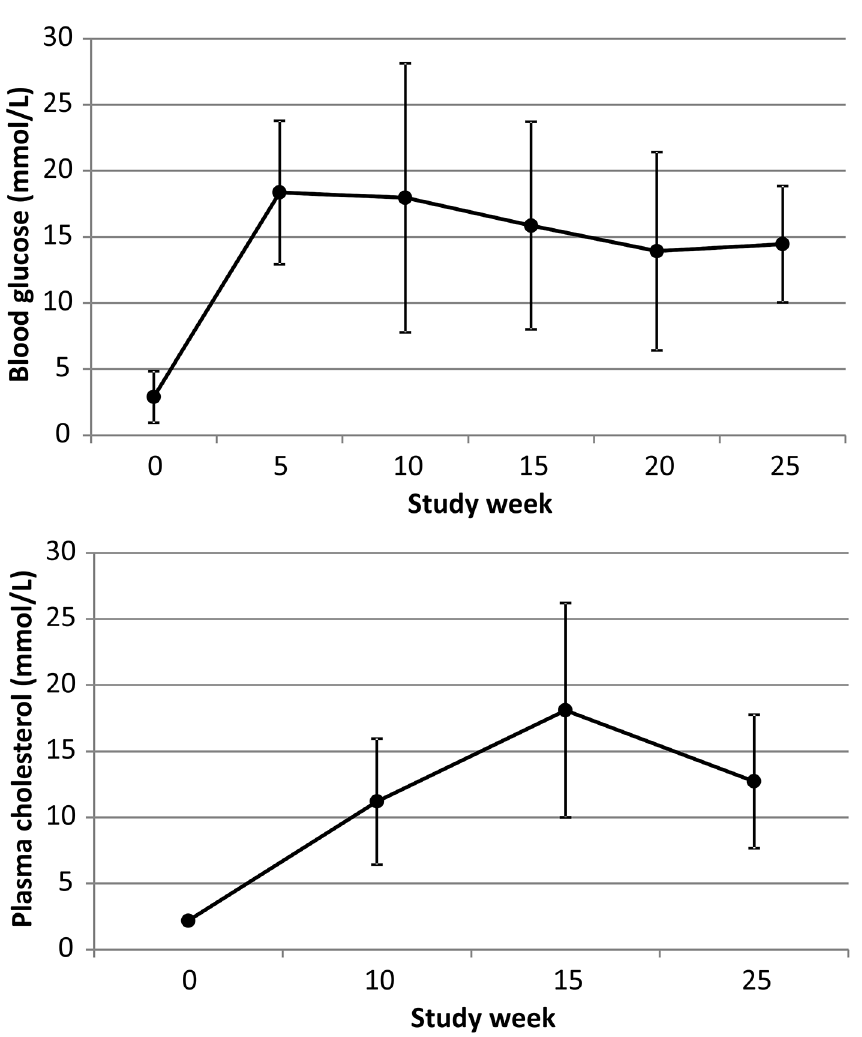
Fig 1. Mean fasting blood glucose and plasma cholesterol levels during 25-week follow up. The first samples (week 0) were obtained on the day of first streptozotozin injection to induce diabetes, whereas high- cholesterol diet began at week 1 and continued until the end of